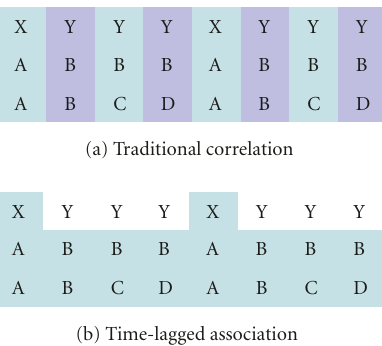
Figure 8: Di ff erent formulations of correlation: (a) traditional cor- relation compares activity at every time instant. In this case, the sequence at the top is perfectly correlated with the one just below it, but the correlation is weaker with the sequence at the bottom. (b) In this case, the time-lagged association with the sequence at the top relative to the symbol X is the same for each of the other two sequences. In the first case, for a time-lag of zero and a win- dow length of 4, the subsequence ABBB is always associated with the occurrence of X. In the second case, for a time-lag of zero and a window length of 4, the subsequence ABCD is always associated with the occurrence of X. In both cases, a consistent subsequence is associated with X and the entropy of activity associated with X is consequently 0.